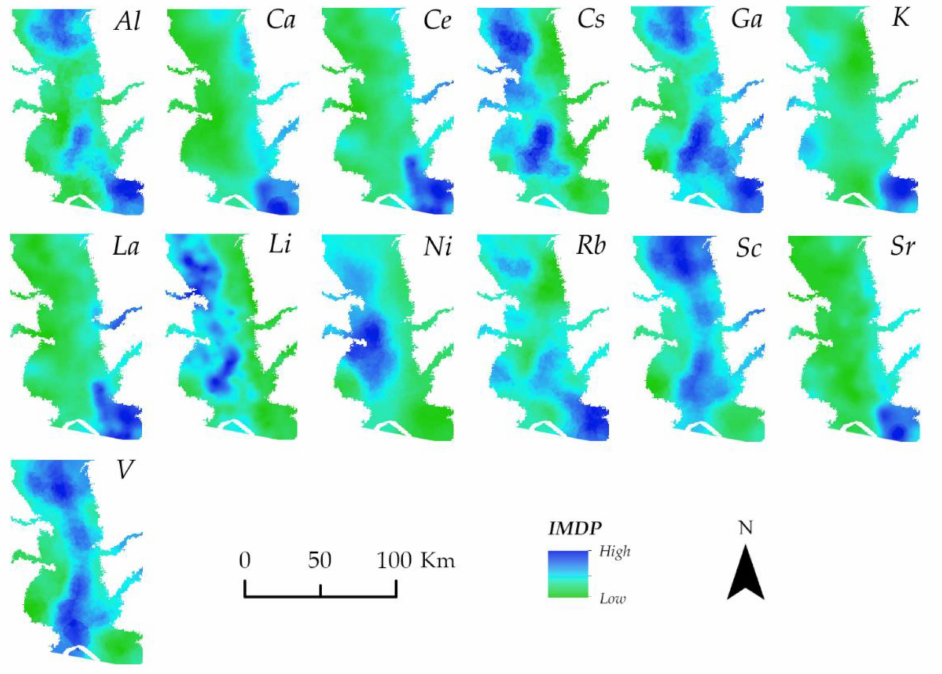
Figure 4. The 13 individual metal distribution patterns are named after the respective metal concen- trations in the topsoil of the Sacramento River floodplain.